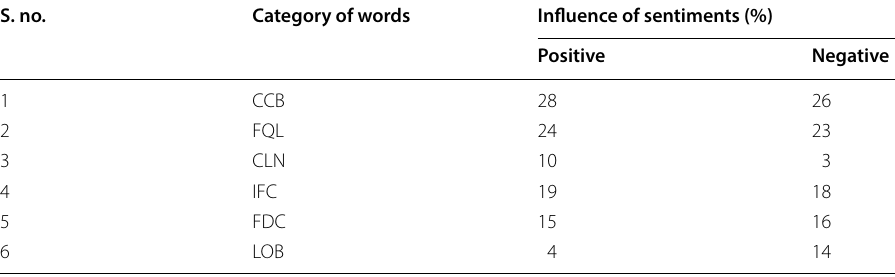
Table 3 Participation of each category of words on sentiments S. no.